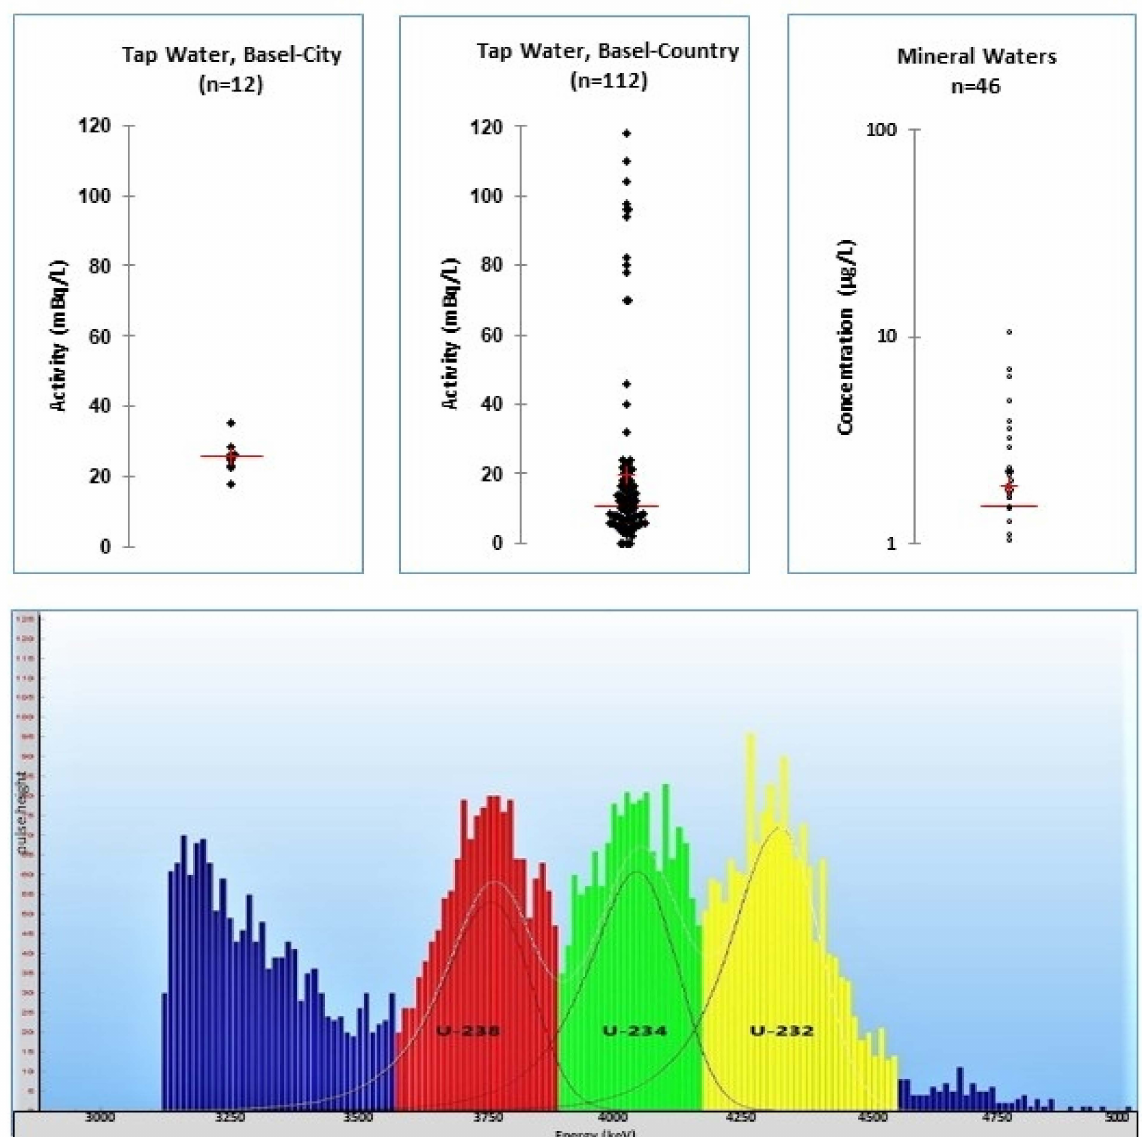
Figure 9. Upper scatter diagrams: tap waters of Basel–City and Basel–Country [35] and mineral waters from the Swiss market [45]. PERALS spectrum of the mineral water San Pellegrino . Note the quenching of more than 500 keV. The found activities were 82 mBq/L 234 U and 76 mBq/L 238 U. Added tracer 232 U: 100